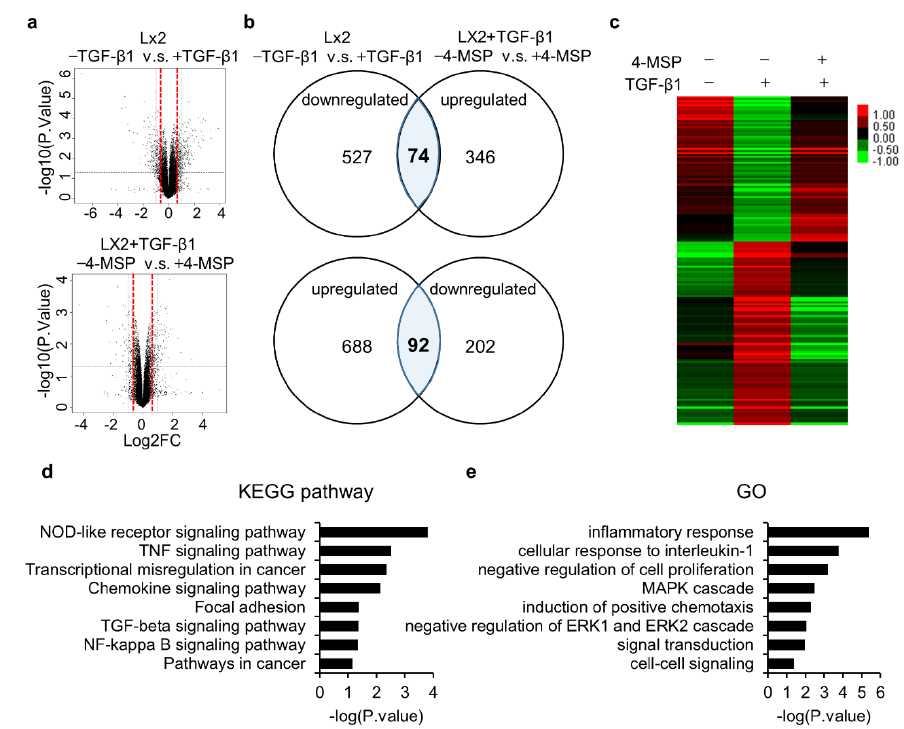
Figure 4. Gene expression profile of TGF- β 1 and 4-MSP-treated LX2 cells. ( a ) The volcano plot shows the distribution of differentially expressed genes according to 1.5-fold change (red axis). ( b ) The Venn diagrams show the correlations for up- and downregulated genes between LX2 ± TGF- β 1 and LX2 + TGF- β 1 ± 4-MSP. ( c ) The heat map of 166 4-MSP-a ff ected genes, based on mRNA microarray analysis. Red and green represent the increase and the decrease in the gene expression levels, respectively. ( d , e ) Kyoto Encyclopedia of Genes and Genomes (KEGG) pathway and Gene Ontology (GO) term enrichment analysis for 166 4-MSP-affected genes.